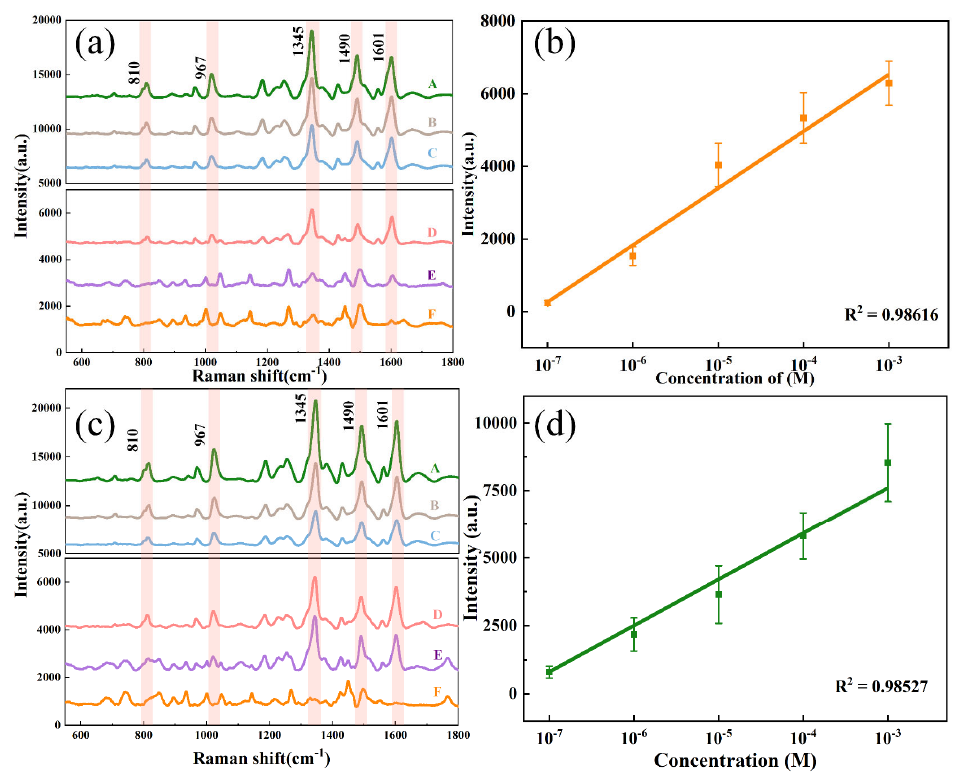
Figure 5. SERS spectrum of nitrofurantoin (A-F:10 − 3 M–10 − 8 M) on the flower-like silver particles ( a ) and quasi-spherical silver particles ( c ) and linear relationship between the SERS intensities at 1345 cm − 1 and the concentration of nitrofurantoin ( b , d ).